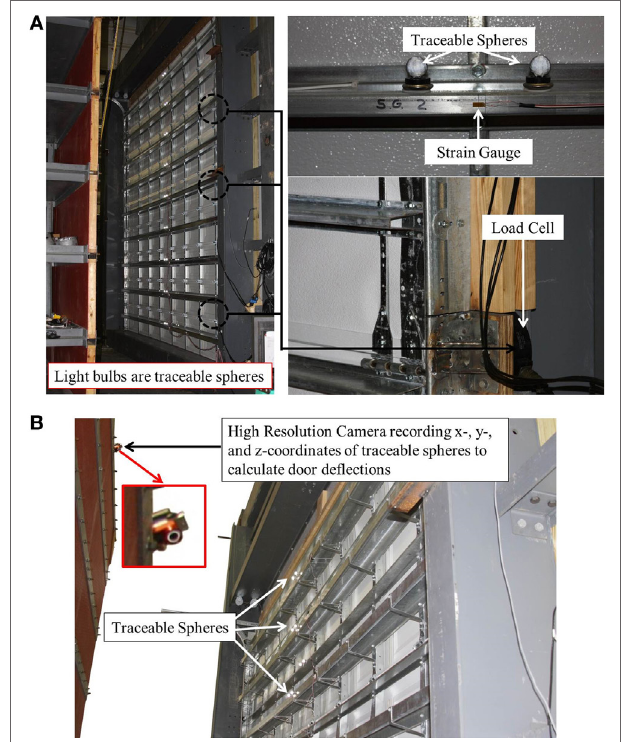
FigUre 7 | instruments used in experimental testing: (a) an overview of instrumentations on Door 4 with focused view of traceable spheres, strain gage, and load cell and (B) an illustration on the deflection measurements .